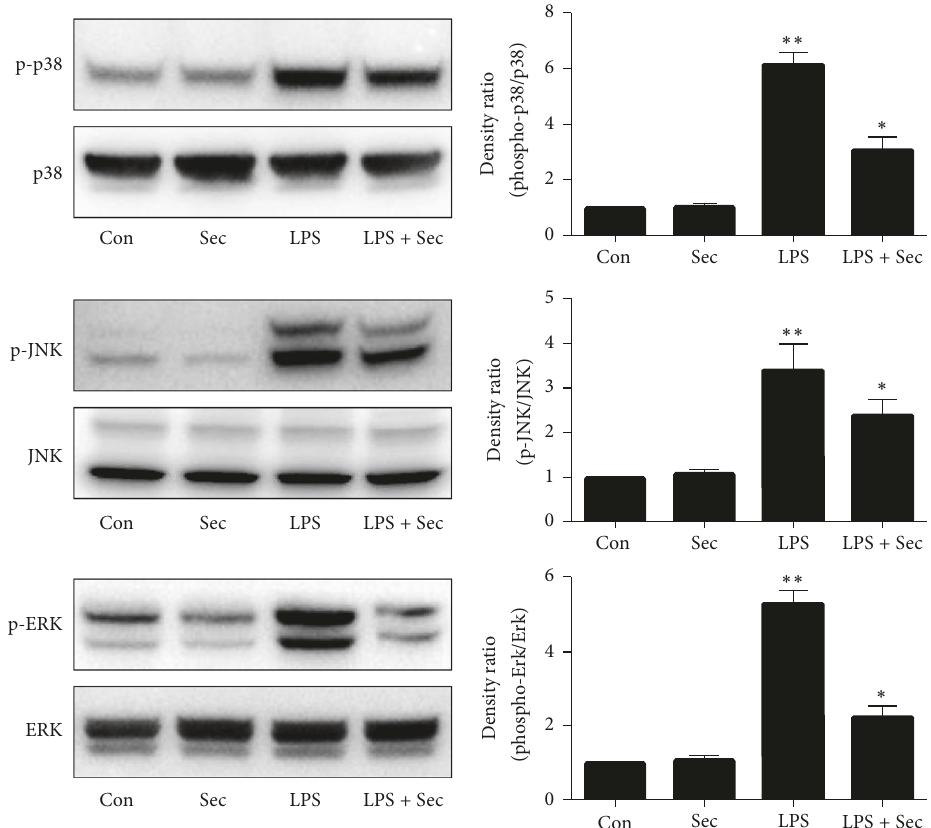
Figure5: Securininereduces LPS-induced MAPKphosphorylation inBV2 microglial cells. BV2 cells werepretreated withsecurinine(10 𝜇 M) for 1h and then exposed to LPS (500 ng/mL) for 30 minutes. Whole cell lysates (50 𝜇 g of protein) were subjected to Western blot analysis using antibodies specific for phosphorylated forms of p38MAPK, ERK1/2, and JNK (mean ± SE, 𝑛 = 4 ). Equal loadings of cell lysates were confirmed by reprobing the blots with total p38MAPK, ERK1/2, and JNK antibodies. The quantification data are shown in the right panel. ∗∗ 𝑃 < 0.01 versus control; ∗ 𝑃 < 0.05 versus